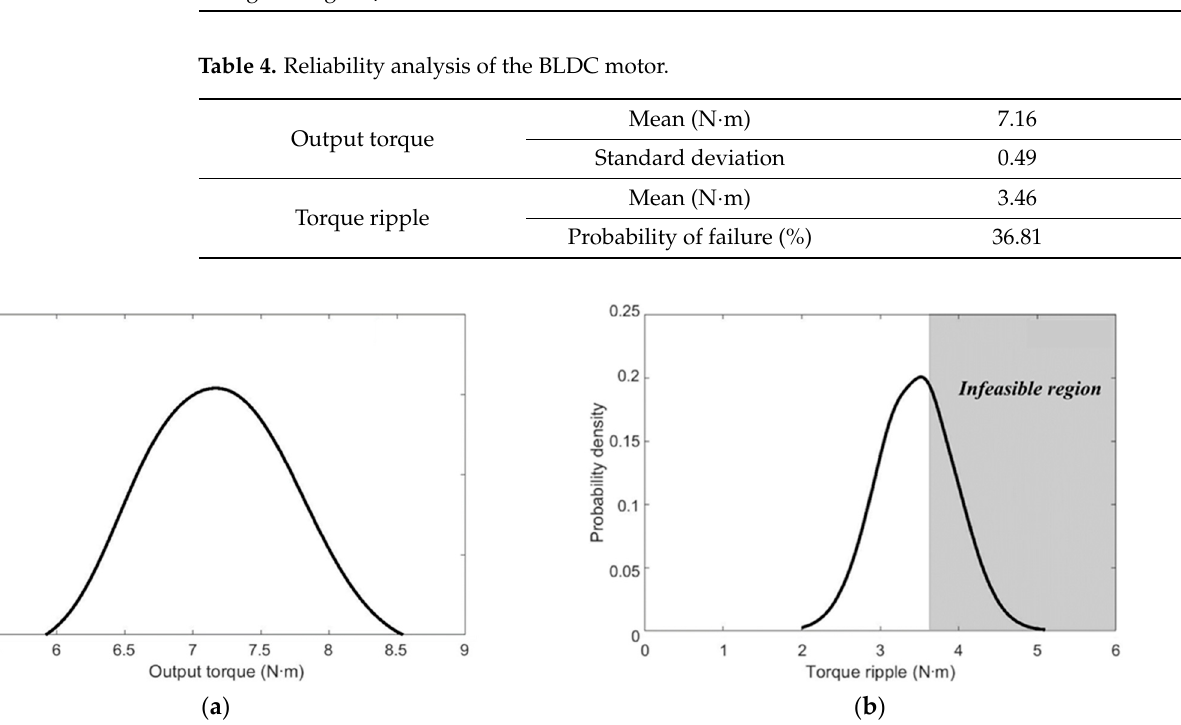
Table 3. Probabilistic distribution of the design variables of the BLDC motor.